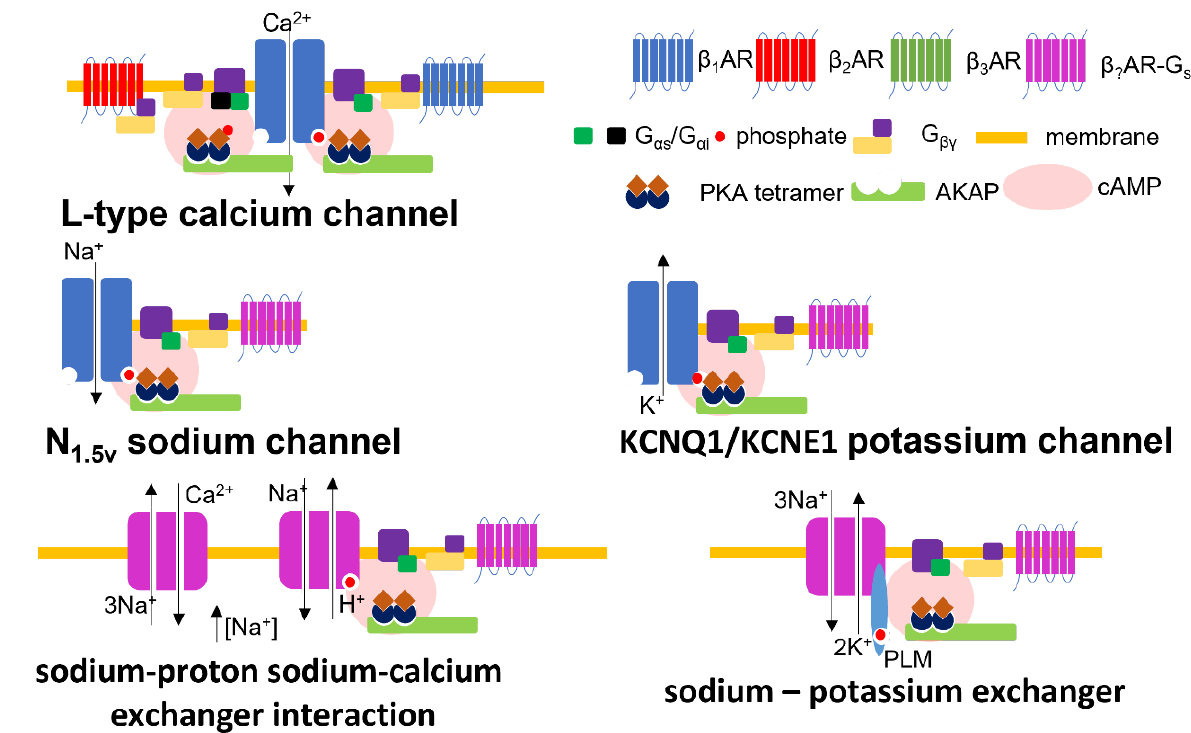
Figure 1. β AR pathways influencing electrophysiology–ion channel membrane complexes. This schematic indicates the suggested molecular complexes between ion channels and β AR subtypes where this is known, along with phosphoryla- tion sites.